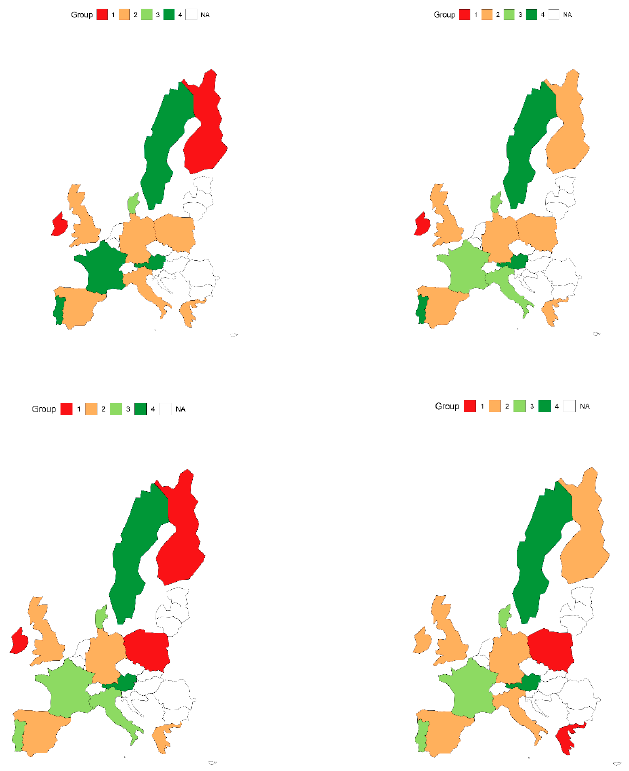
Energies 2022 , 15 , x FOR PEER REVIEW Figure 7. SISED for individual EU countries in 2011–2014. Figure 7. SISED for individual EU countries in 2011–2014.